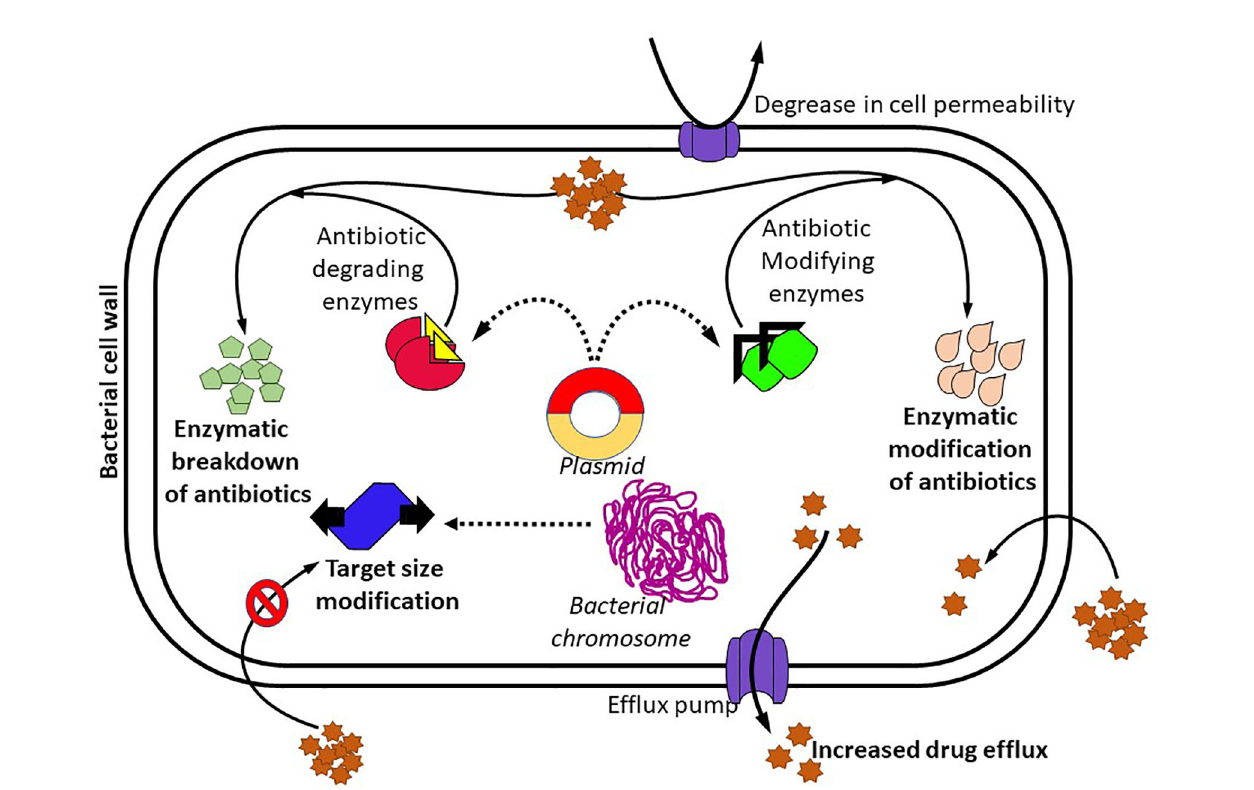
FIGURE 1 | Molecular mechanisms of bacteria resisting